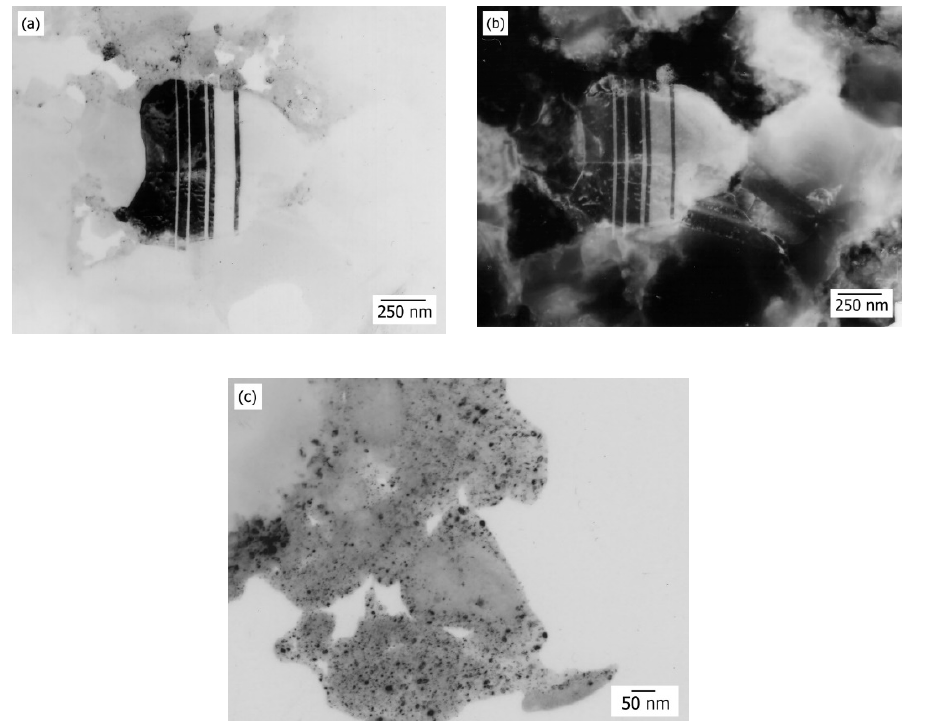
Figure 4. TEM analysis of sample after sintering: BF (bright field) and DF (dark field) images showing nano-twinning on Cu crystal ( a , b ) , homogenous distribution of Al 2 O 3 particles ( c )